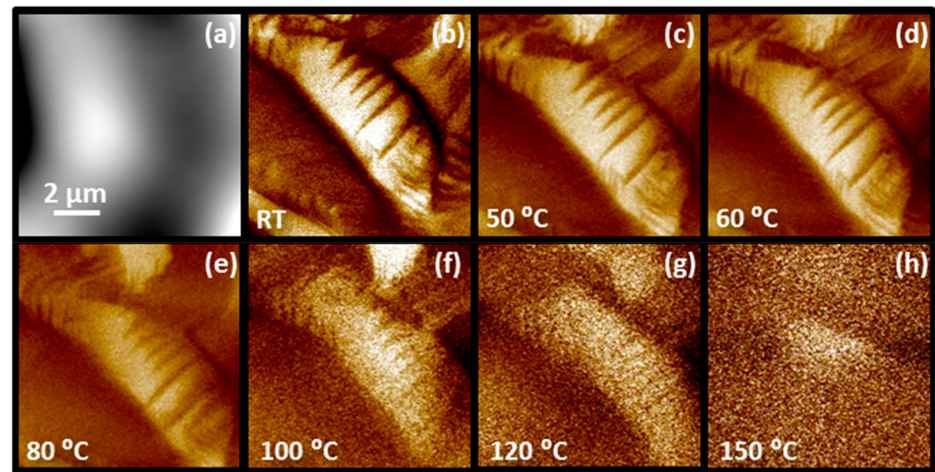
Figure 5. ( a ) Topography and out-of-plane PFM amplitude images of the same area ( b ) before and ( c – h ) after heating (drive AC signal: 5 V, 310 kHz).